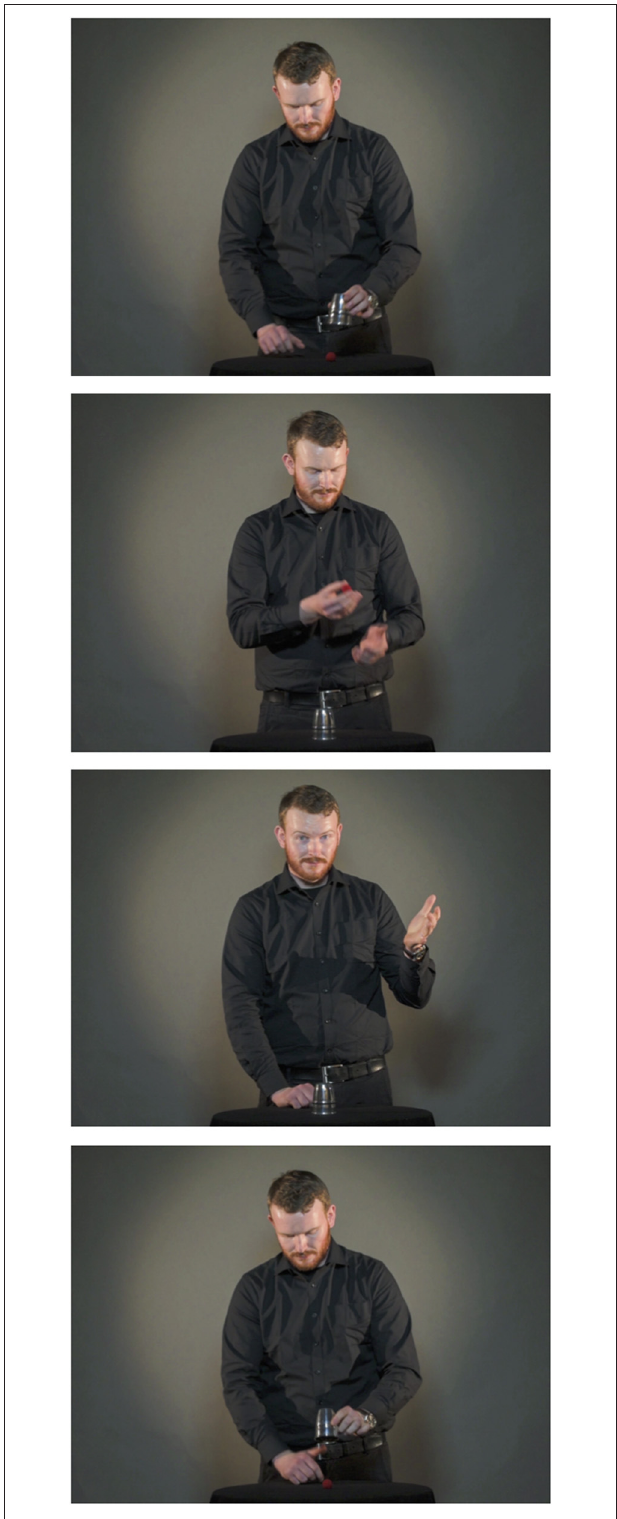
FIGURE 2 | Picture sequence illustrating the magic trick Chop cup (Example 2). The full clip is available at https://www.youtube.com/watch?v=